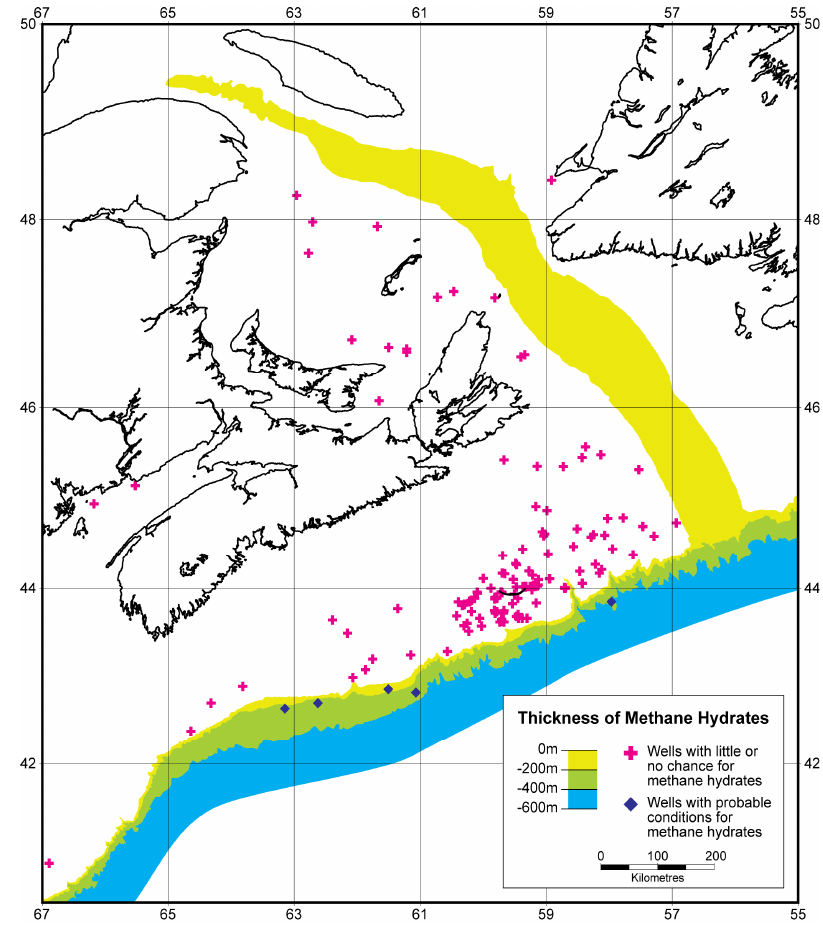
Figure 15. Predicted Atlantic Margin GH thickness offshore Nova Scotia (modified from